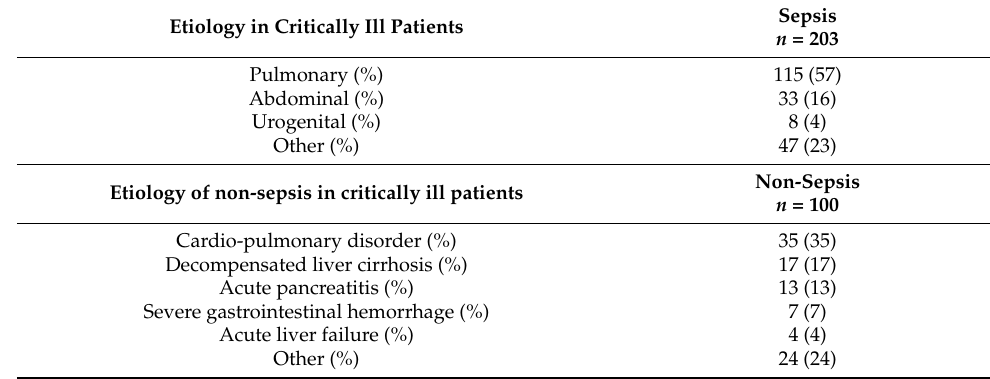
Data are shown in absolute numbers and % (in